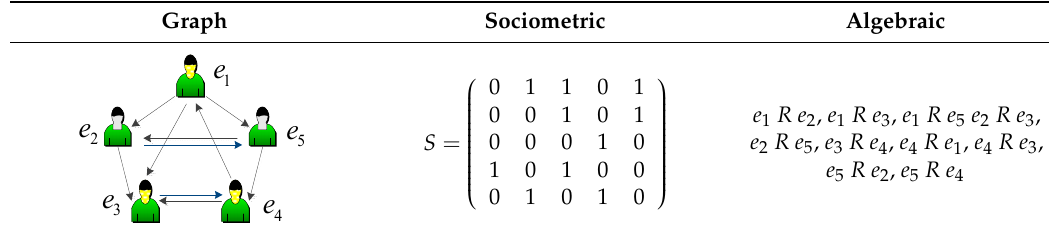
Table 2. Di ff erent representation schemes in social network analysis (SNA). Table 2. Different representation schemes in social network analysis